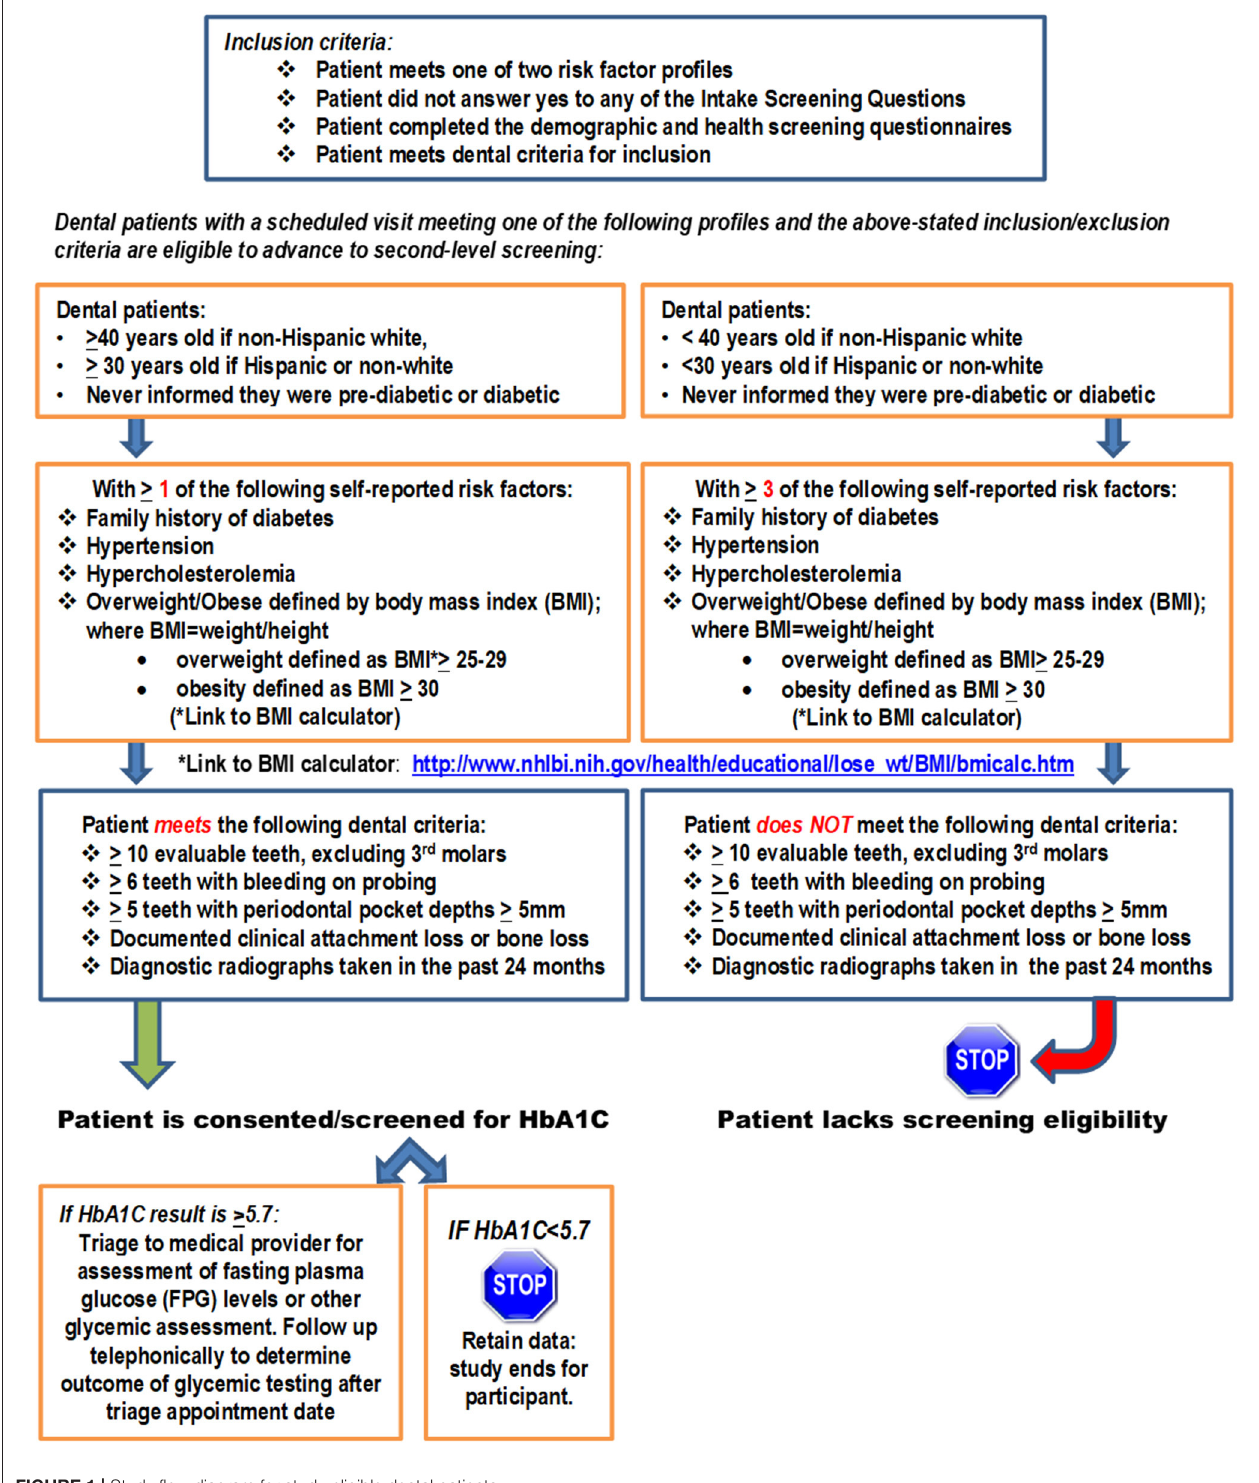
cationic exchange high-performance liquid chromatography with high fidelity and accuracy [17]. The instrument was supplied to the study team through the 17VNPL